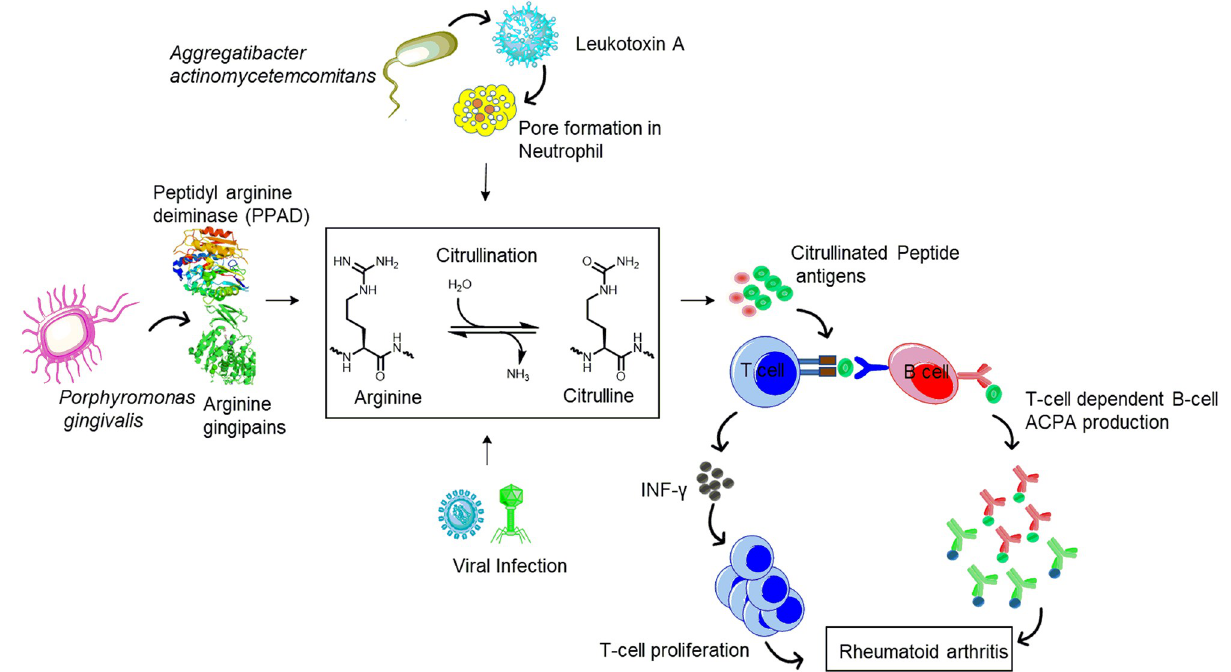
Fig 1. Schematic representation of citrullinated peptide in rheumatoid arthritis development.